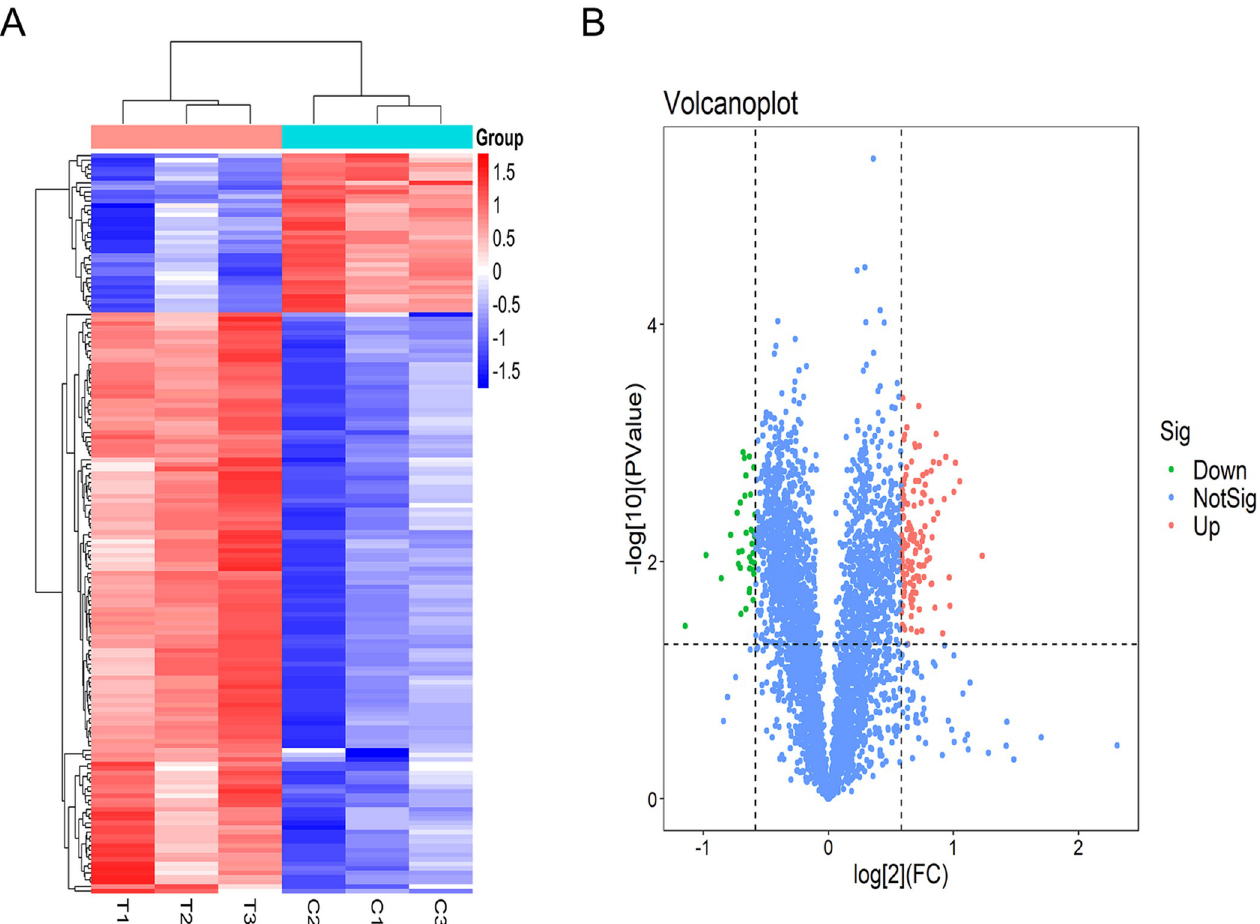
Fig 2. The overview of global changes of identified proteins. (A) The identified proteins expression profile by heatmap plot. T1, T2 and T3, and C1, C2 and C3 respectively represented 3 tail suspension samples and 3 control samples. (B) Volcano plots of fold-change vs. -log 10 p-value of identified proteins. The significance threshold was set at p-value � 0.05. The significant differentially expressed proteins were marked with different colors, the upregulated proteins were marked in pink, downregulated proteins were marked in green, and blue dots indicated no significant difference. FC, fold